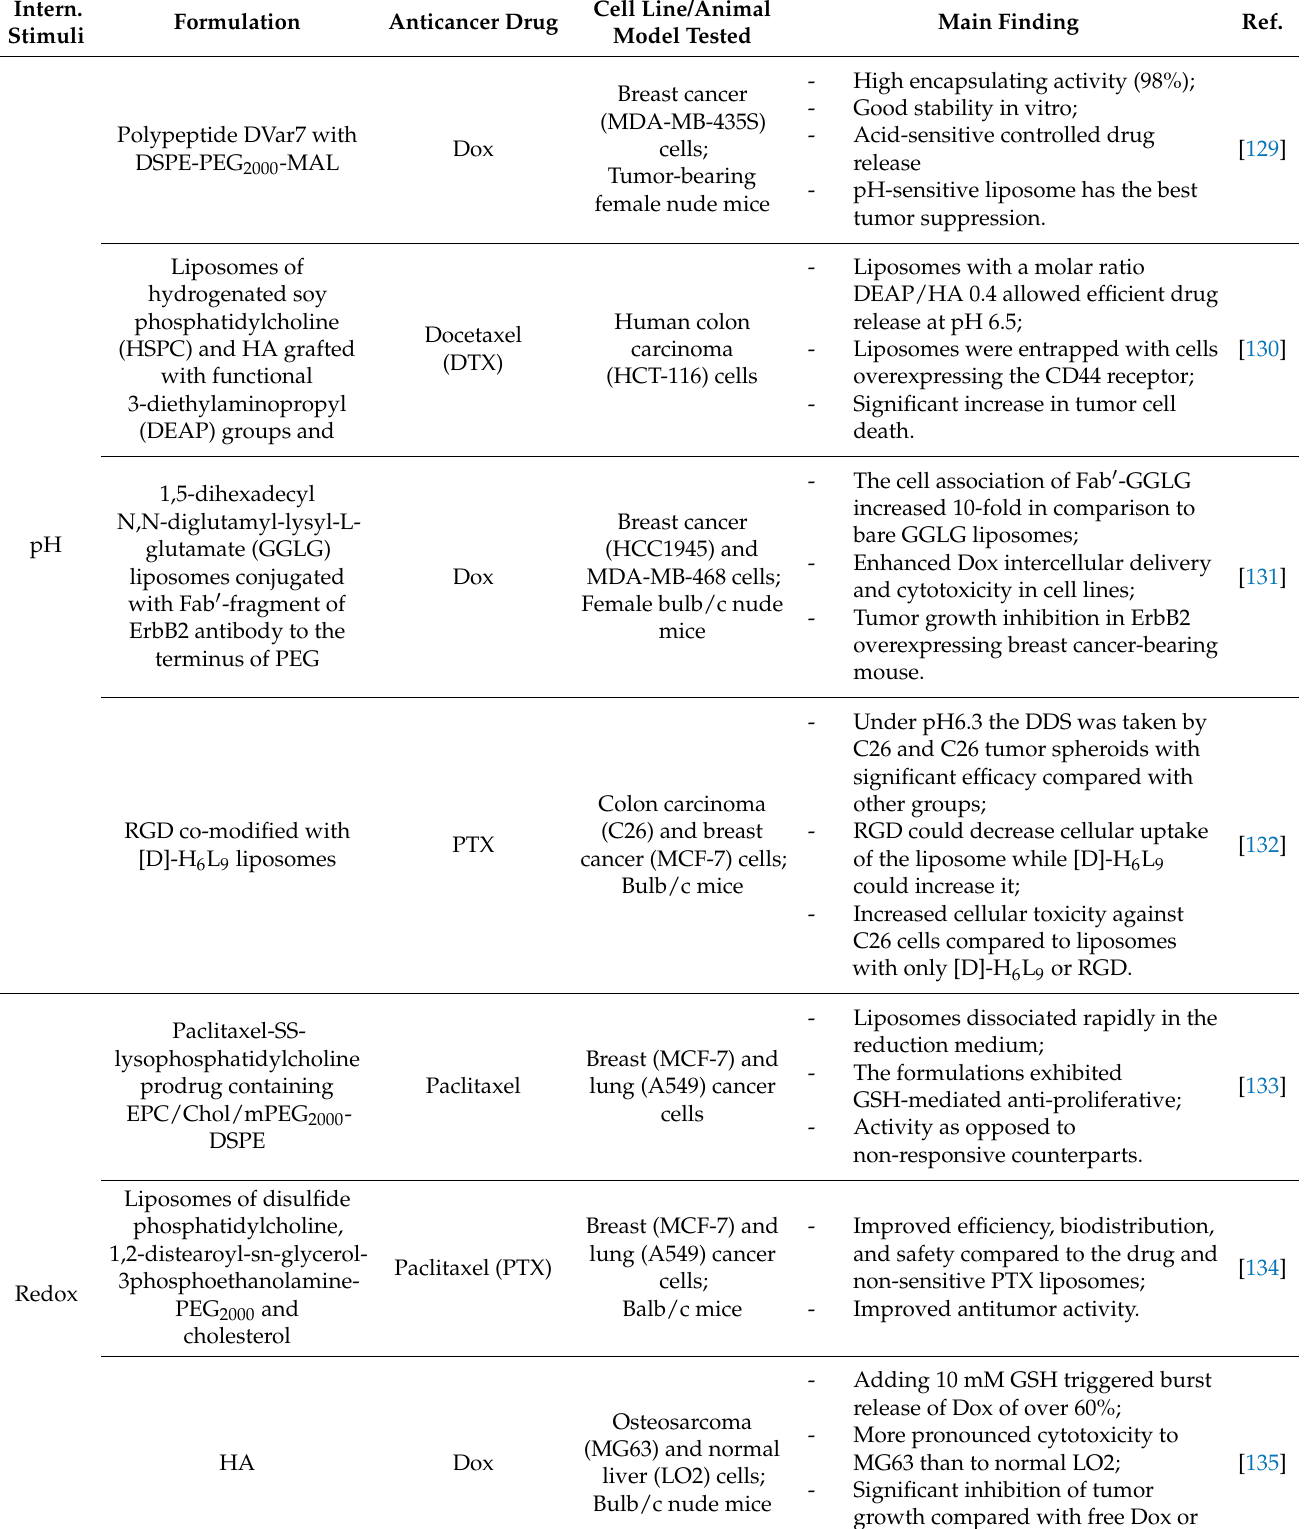
Table 3. Recent studies focusing on internal stimuli-activated liposomal